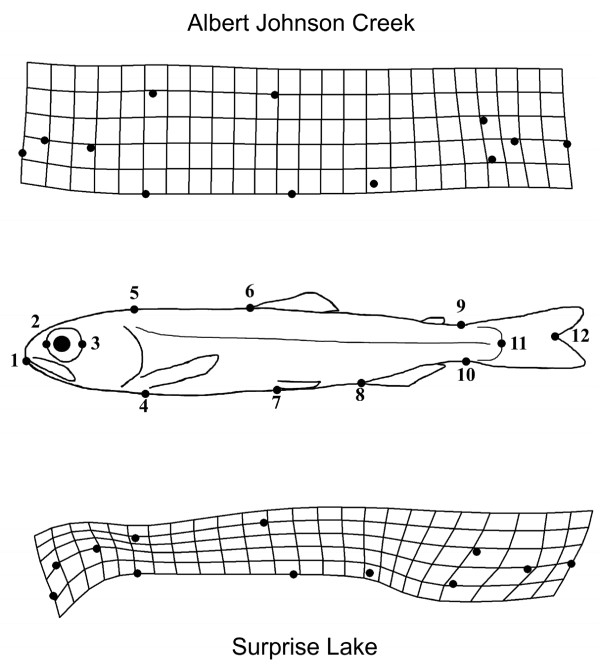
Landmarks used and deformation grids of Albert Johnson Creek (AJC) and Surprise Lake (SL) fish. The middle panel depicts the locations of the twelve landmarks used in the geometric morphometric comparison of body shape. the top and bottom panels depect the details of the shape differences of these populations from ecolgically different habitat between AJC (top) and SL (bottom).